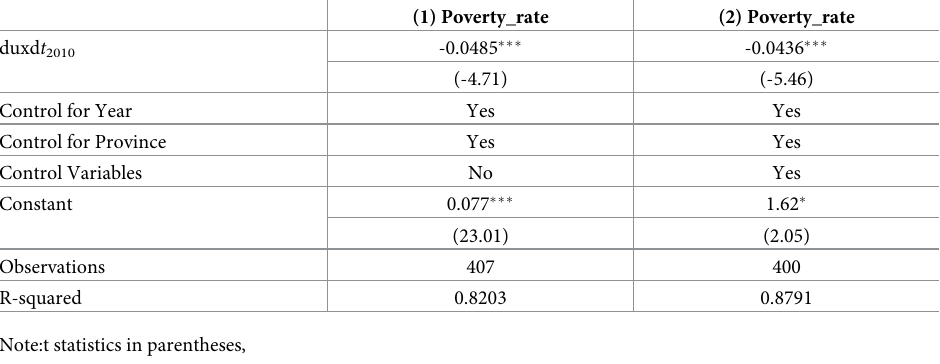
Table 3. Result of benchmark model of DID.